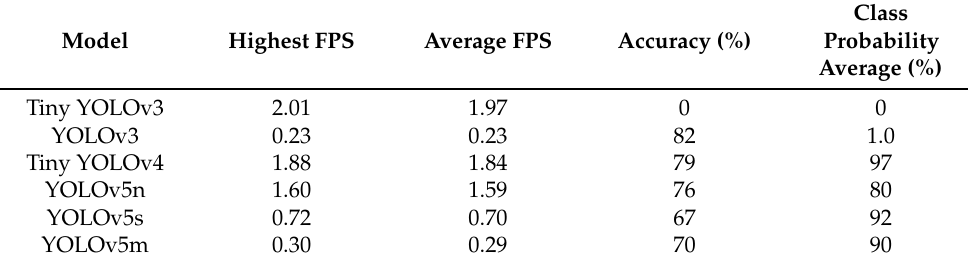
Table 4. Raspberry Pi 4 results comparing the YOLO models.